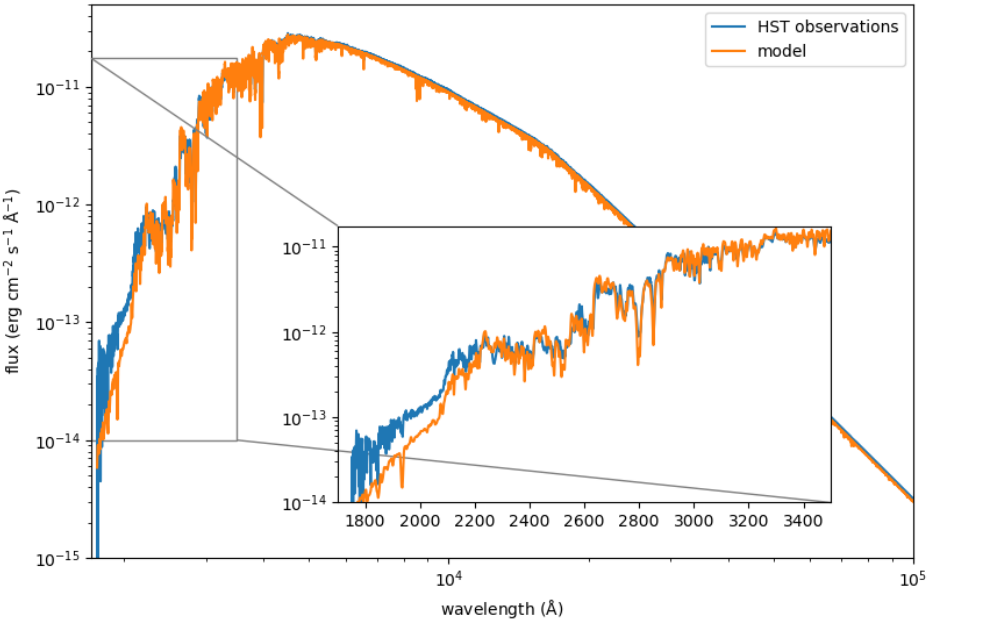
Figure 4. Observed (blue) and model (orange) spectra for the solar twin 18 Sco. The model has been scaled using the determination of the star’s angular diameter from